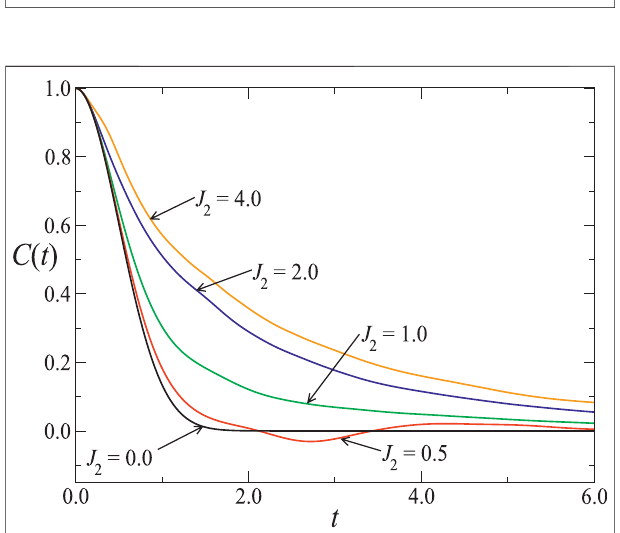
FIGURE 4 | Spectral density for B (cid:2) 0 . 5 and several values of J 2 . All the curves were obtained for chains with L (cid:2) 12 spins [17].